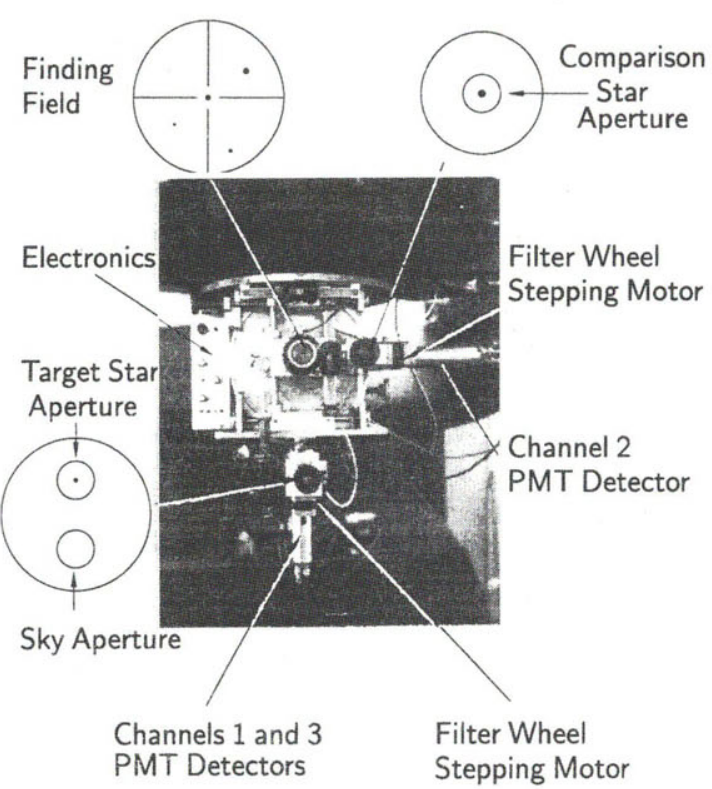
Fig. 1. The WET photometer mounted on the McDonald 36" tele- scope and the view from each